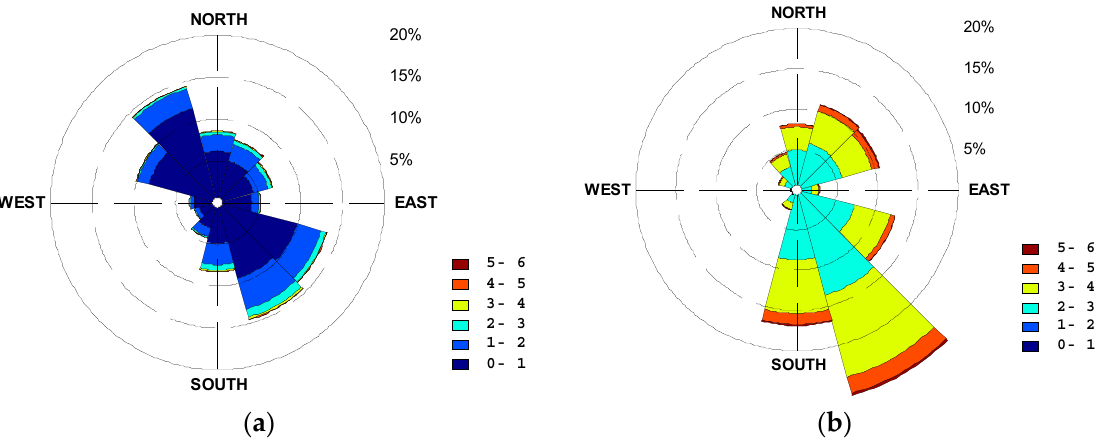
Figure 5. Wave roses for the entire Adriatic basin: ( a ) all sea states and ( b ) sea states with Hs > 2.5 m . There is a noticeable amount of smaller N–NW waves accounted to the same direc- tion ( maestral/maestrale) wind—a typical daily coastal circulation, caused by temperature oscillation between land and sea during summer months, which is important to the leisure nautical sector due to its predictability and mild character. Regional wave roses are avail- South and Central Adriatic and NE high wave dominance in the North Adriatic